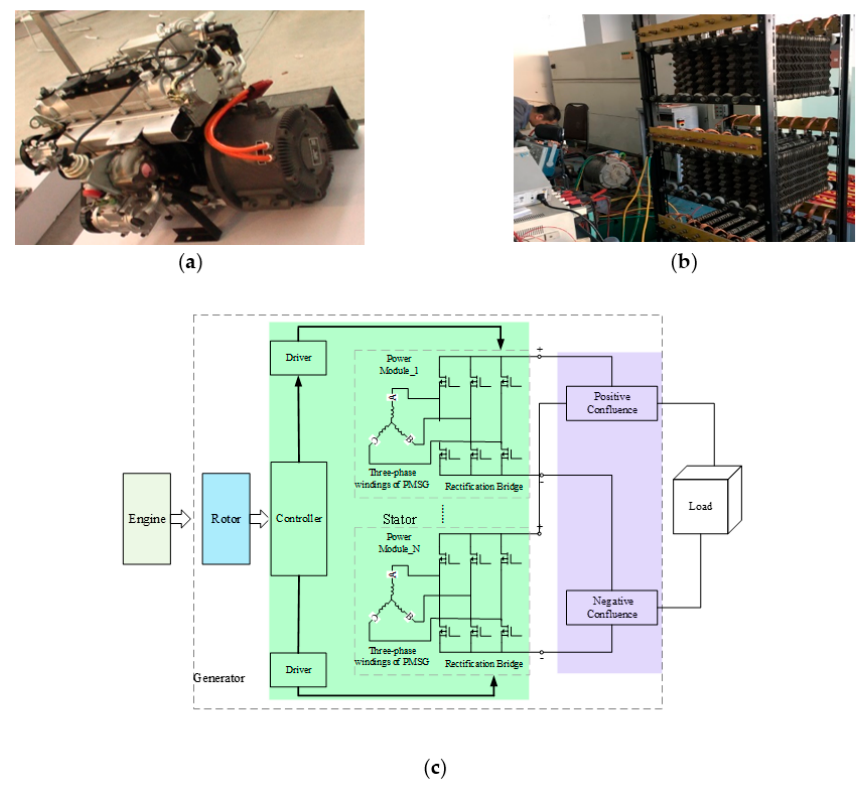
Figure 13. Large current load experiment of the integrated DC output system: ( a ) Experimental platform; ( b ) load experiment; ( c ) the schematic of the synchronous system.